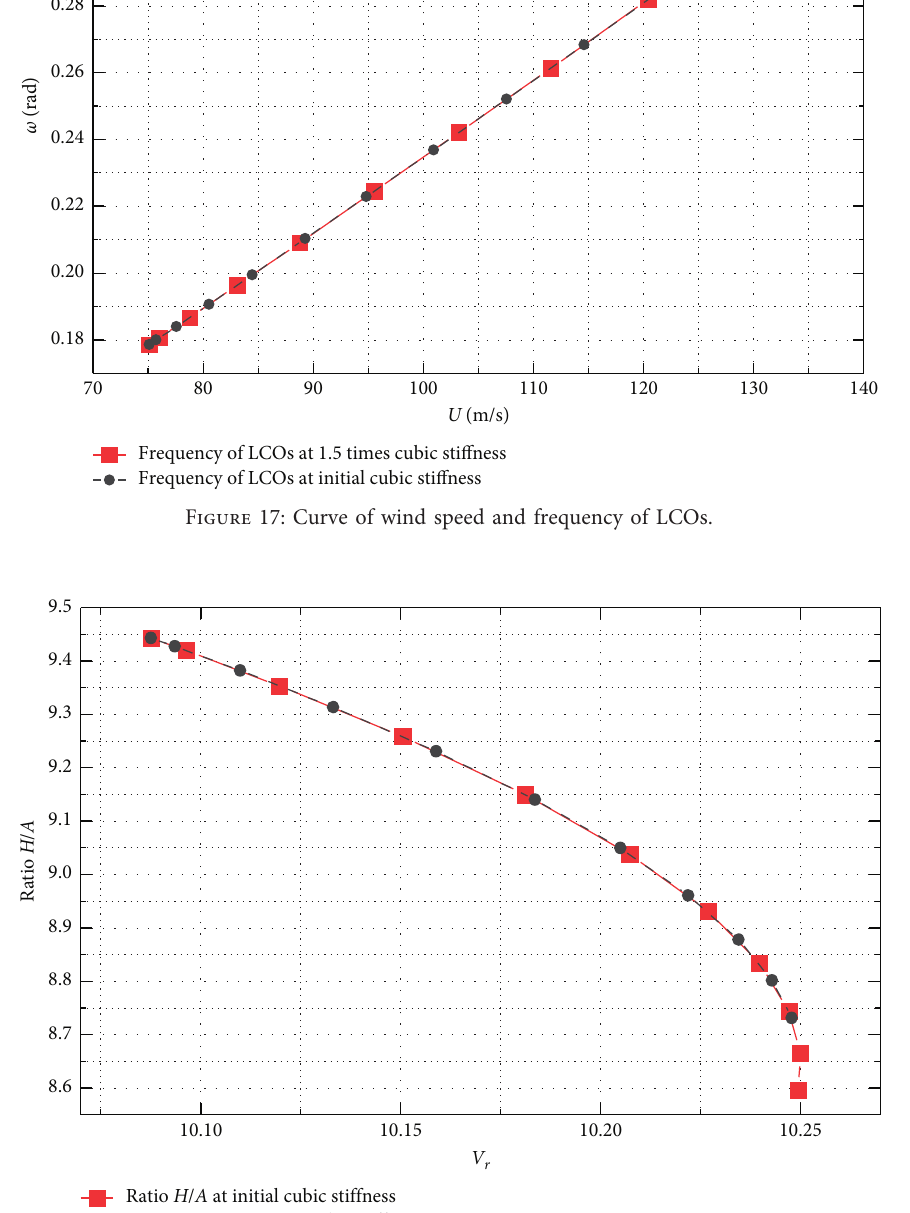
Figure 18: Curve of reduced wind speed and vertical-torsional